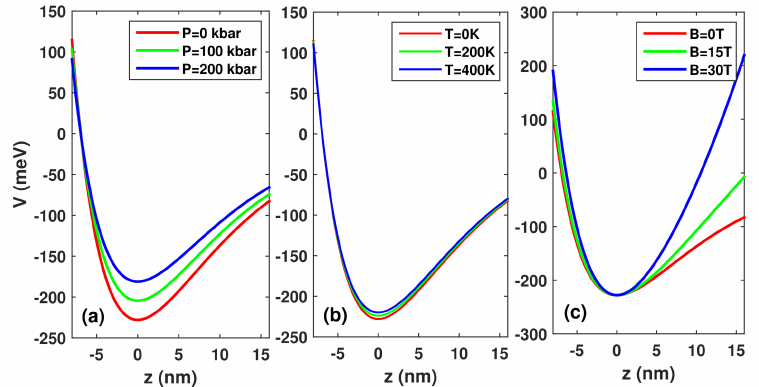
Figure 1. The variation in the confinement potential profile of morse quantum wells (QWs) for three different hydrostatic pressure P ( a ), temperature T ( b ), and applied magnetic field B ( c )